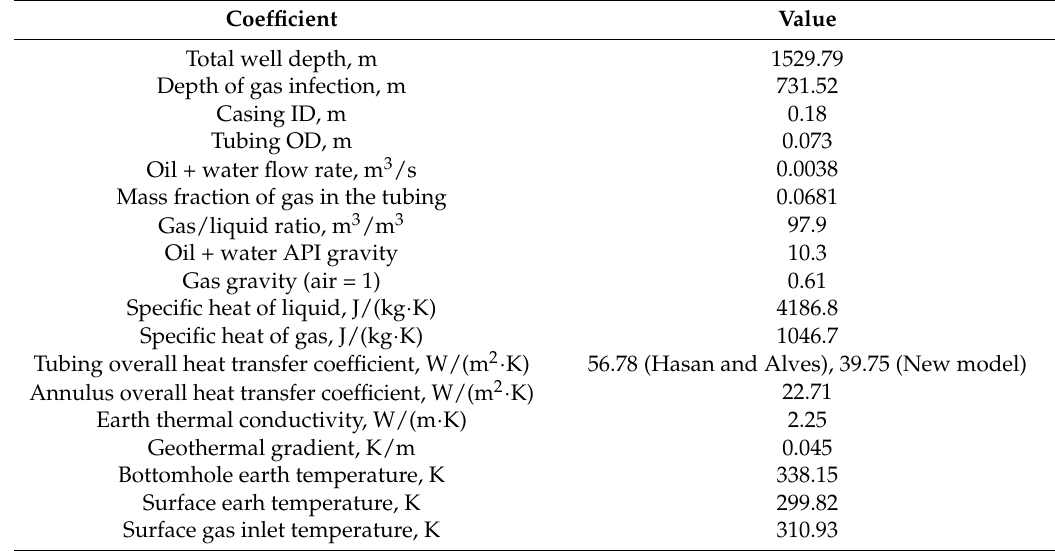
Table 5. Data for the Thompson Well.